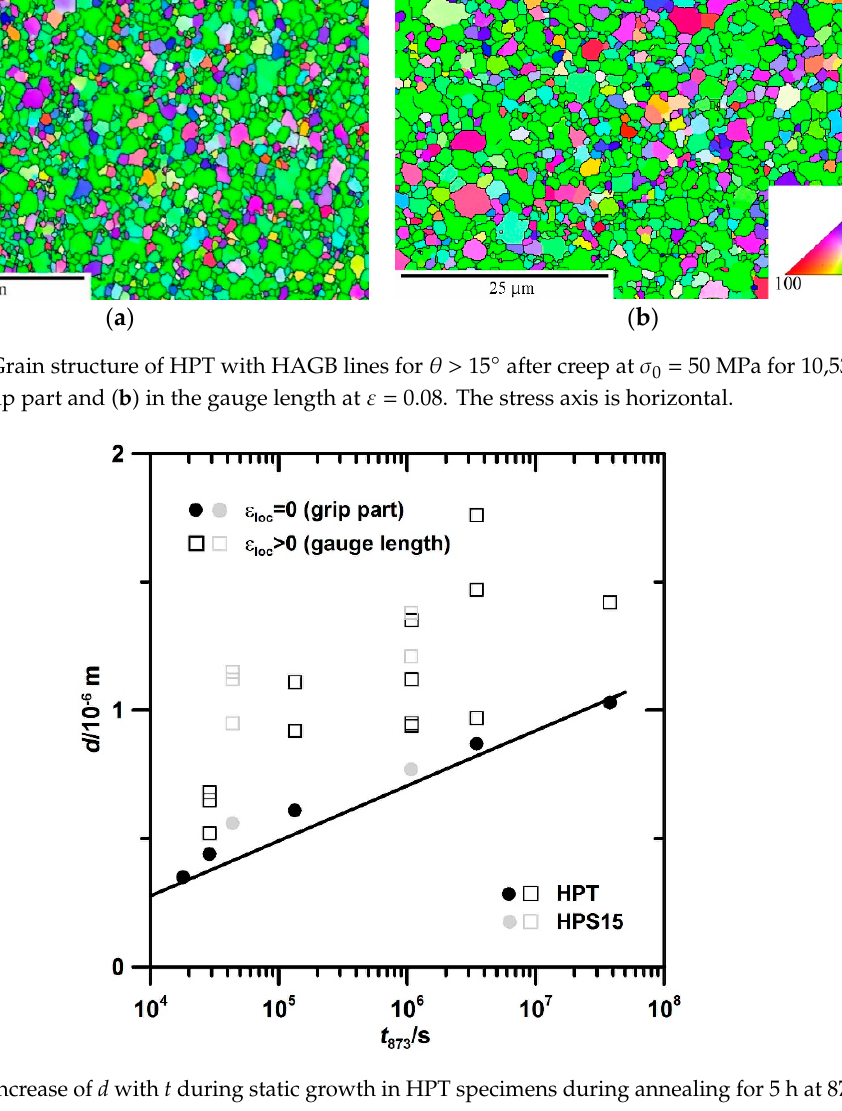
Figure 14. Increase of d with t during static growth in HPT specimens during annealing for 5 h at 873 K and subsequent creep at different stresses and times to fracture.